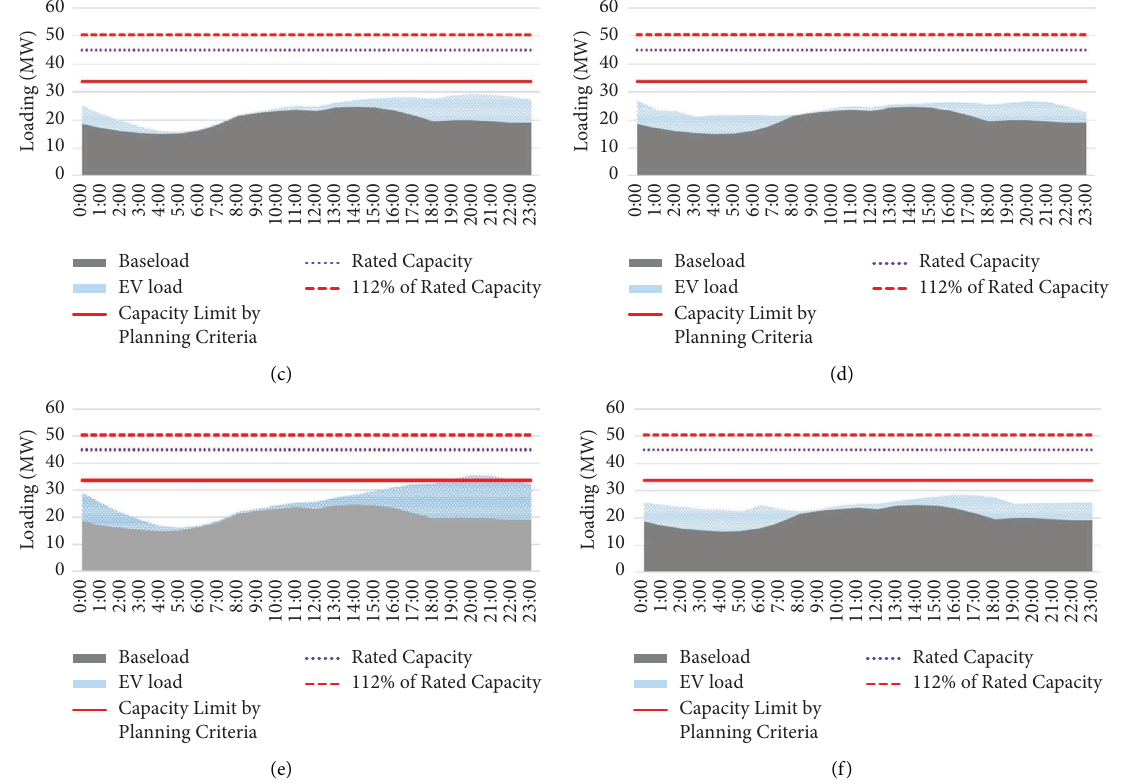
Figure 18: Capacity loading of substation transformer under the three scenarios of EV penetration for uncoordinated and smart charging. Substation transformer loading for (a) uncoordinated charging and (b) smart charging for 10% EV penetration. Substation transformer loading for (c) uncoordinated charging and (d) smart charging for 30% EV penetration. Substation transformer loading for (e) un- coordinated charging and (f) smart charging for 50% EV penetration.